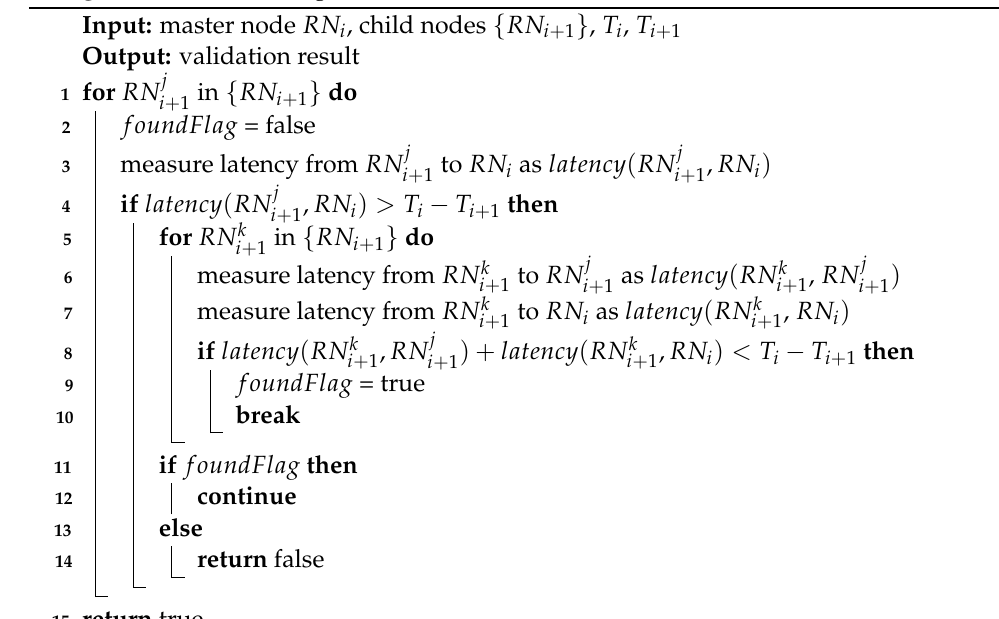
Algorithm 1: Index Neighbor Existence